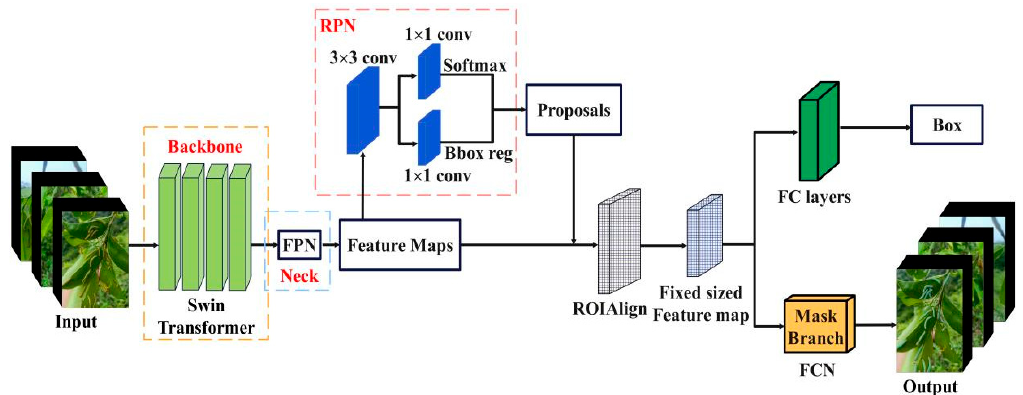
Figure 2. Framework of pest segmentation based on improved Mask